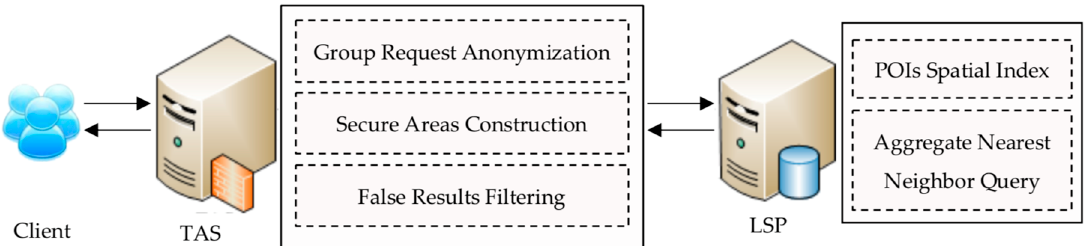
Figure 4. Details of our system architecture.